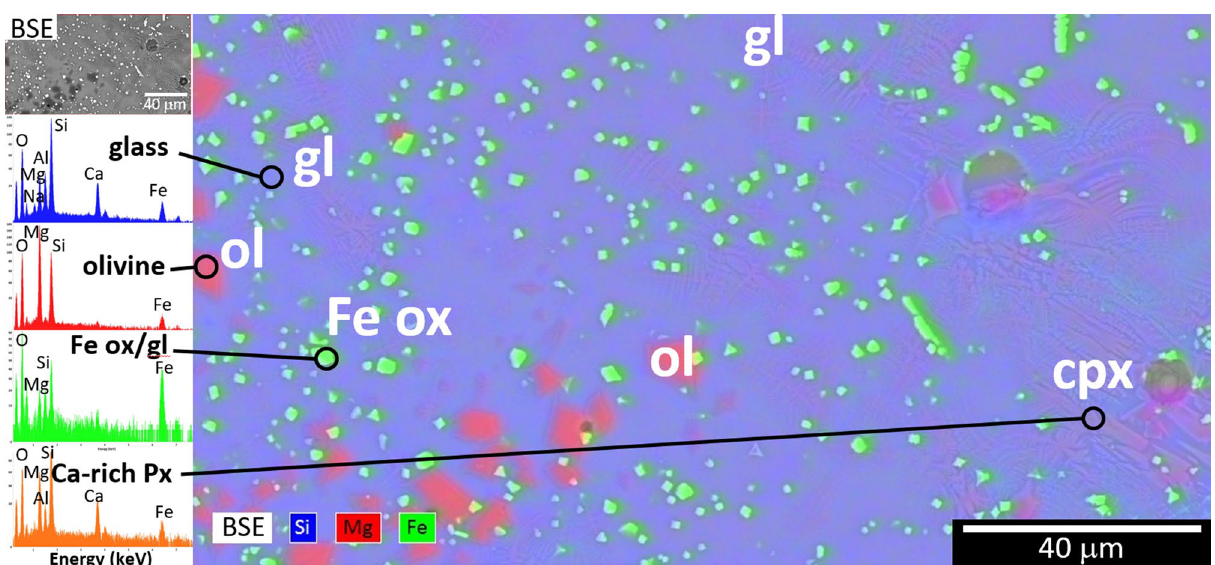
Figure 8. Microstructure and chemistry of heat-treated amphibolite BA5 (1200-P-L-Q condition: rock chunk heated to 1200 °C in Pt, held 15 min then quenched in air). SEM-BSE image and SEM–EDS map, colored according to phases with shown X-ray fluorescence spectra. The liquidus phases precipitating from the glass were a Fe–Mg–Al spinel and Mg-rich olivine. Clinopyroxene (augite) quench crystals were also observed. Different phases were seen in other regions, including quartz and